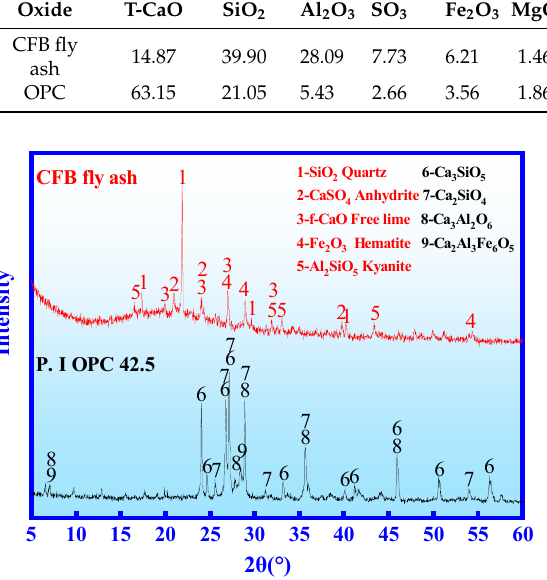
Table 1. Chemical components of CFB fly ash and OPC (wt.%). Note: LOI: Loss of ignition at 800 °C. Oxide T-CaO SiO 2 Al 2 O 3 SO 3 The XRD of CFB fly ash and OPC is provided in Figure 1. The main phase of CFB fly ash are SiO 2 , f ‐ CaO, CaSO 4 , Fe 2 O 3 and Al 2 SiO 5 . CFB fly ash contains many glassy amor ‐ phous phases. The main minerals in OPC are Ca 3 SiO 5 , Ca 2 SiO 4 , Ca 3 Al 2 O 6 and Ca 2 Al 3 Fe 6 O 5 .